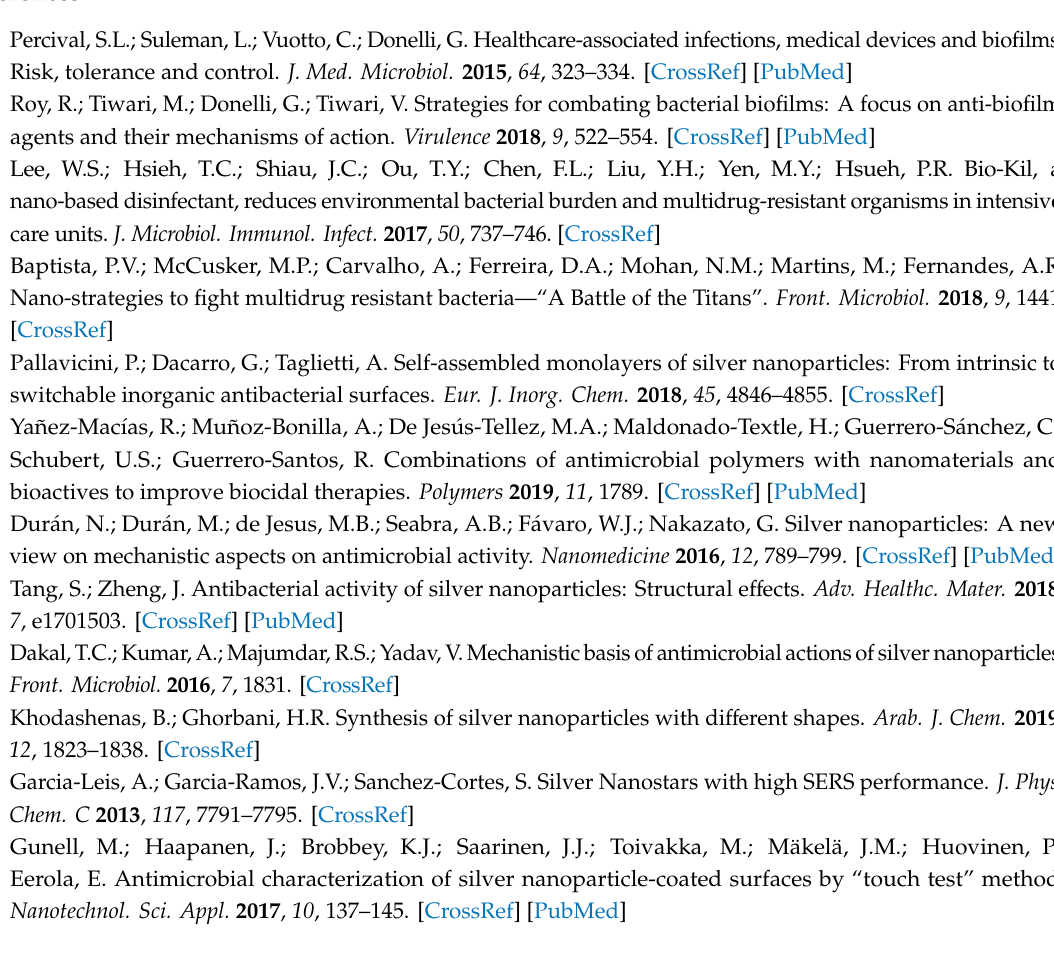
Figure S1: Hydrodynamic diameter distributions for AgNSs (A) and AgNPs (B), obtained by nanoparticle tracking analysis, Figure S2: Scanning electron microscopy micrographs of AgNSs, Figure S3: Photograph of the AgNSs-coated surfaces, Figure S4: Scanning electron microscopy micrographs of AgNSs-coated glass